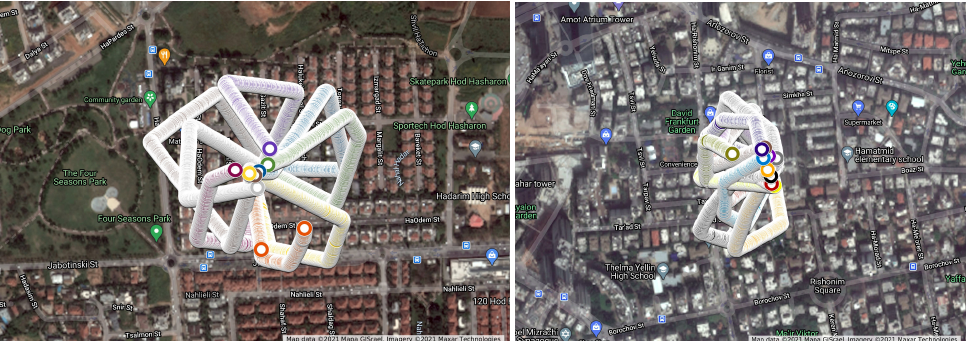
Figure 10. The drone flight route for location #1 (the left image) and location #2 (the right image) from an altitude of 50 m.